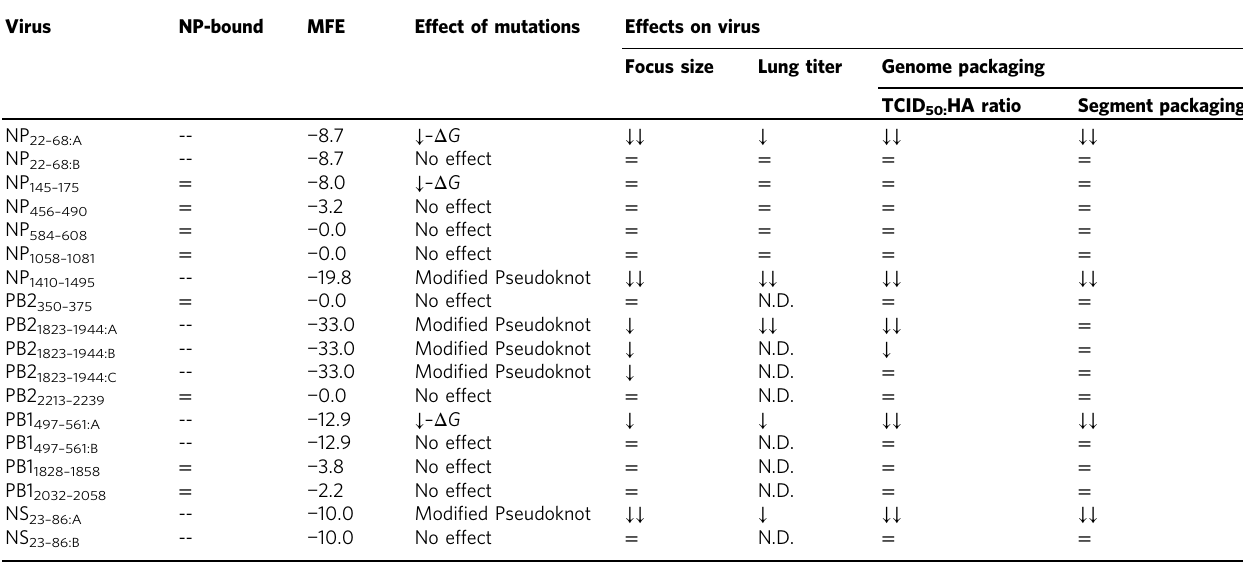
For NP-binding, the following categories were considered: --, signi fi cantly lower than WT-PR8; = , equal to WT-PR8; ++, greater than WT-PR8. The regional stability was determined in WT-PR8 and